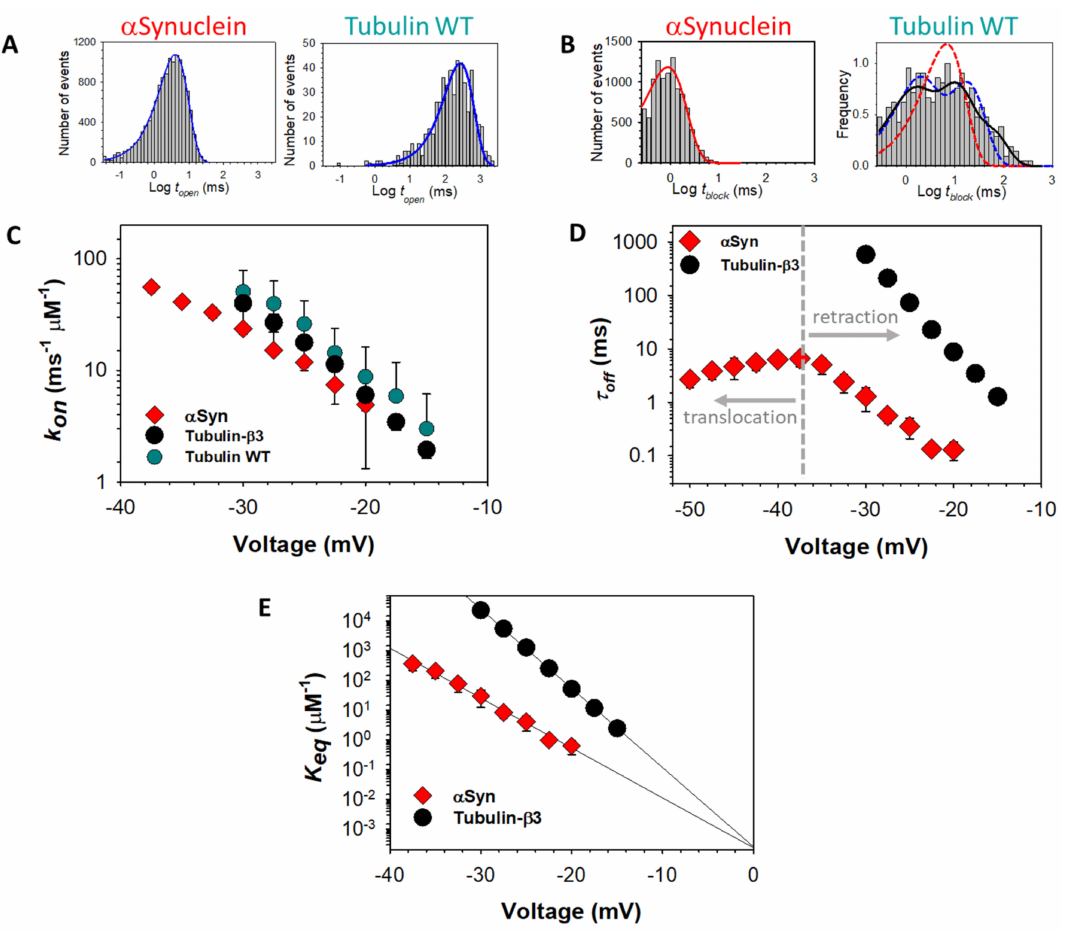
Figure 6. Distributions of ( A ) open and ( B ) blocked state times for VDAC exposed to tubulin and α Syn. ( C ) The capture rate is exponentially dependent on the transmembrane potential and is similar for both inhibitors. ( D ) The release rate is also exponential in voltage for tubulin and α Syn at low voltages but is more complex for α Syn at higher voltages, indicating the onset of α Syn translocation through VDAC. ( E ) The equilibrium constant, extrapolated to zero voltage, reveals the entropy of insertion, which is the same for the C-terminal domains of tubulin and α Syn and points to a common mechanism of interaction. VDAC isolated from rat liver mitochondria was reconstituted into PLM made of diphytanoyl- phosphatidylcholine in membrane-bathing 1 M KCl solution buffered with 5 mM HEPES at pH 7.4. Distributions of open ( A ) and blocked ( B ) times were obtained in the presence of 50 nM α Syn and 20 nM wild-type tubulin at − 25 mV ( A ) and − 30 mV ( B ) of applied voltage. Data were adapted from Rostovtseva et al., J. Biol. Chem . (2018) and Rostovtseva et al., J. Biol. Chem . (2015) and used in newly generated figures ( C – E ). Data points denote mean values from independent repeated experiments; error bars show the 68% confidence interval of the